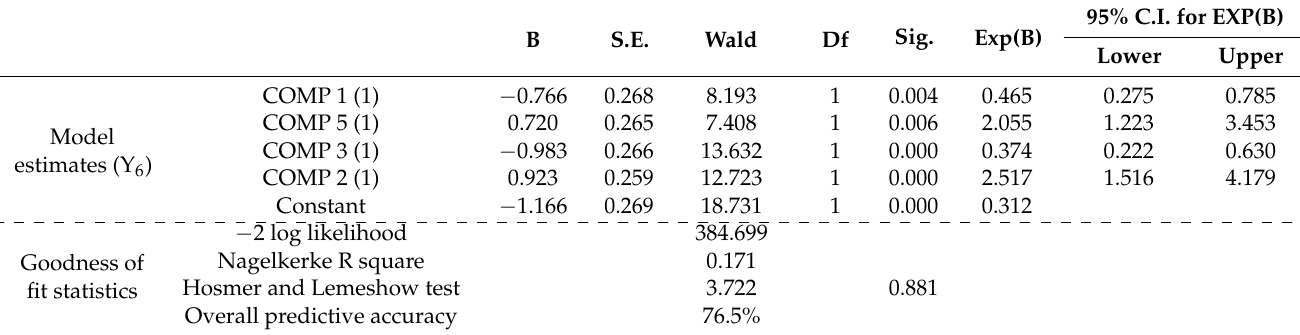
Table 12. Multivariate regression results between reduction of household income and predictor variables. B